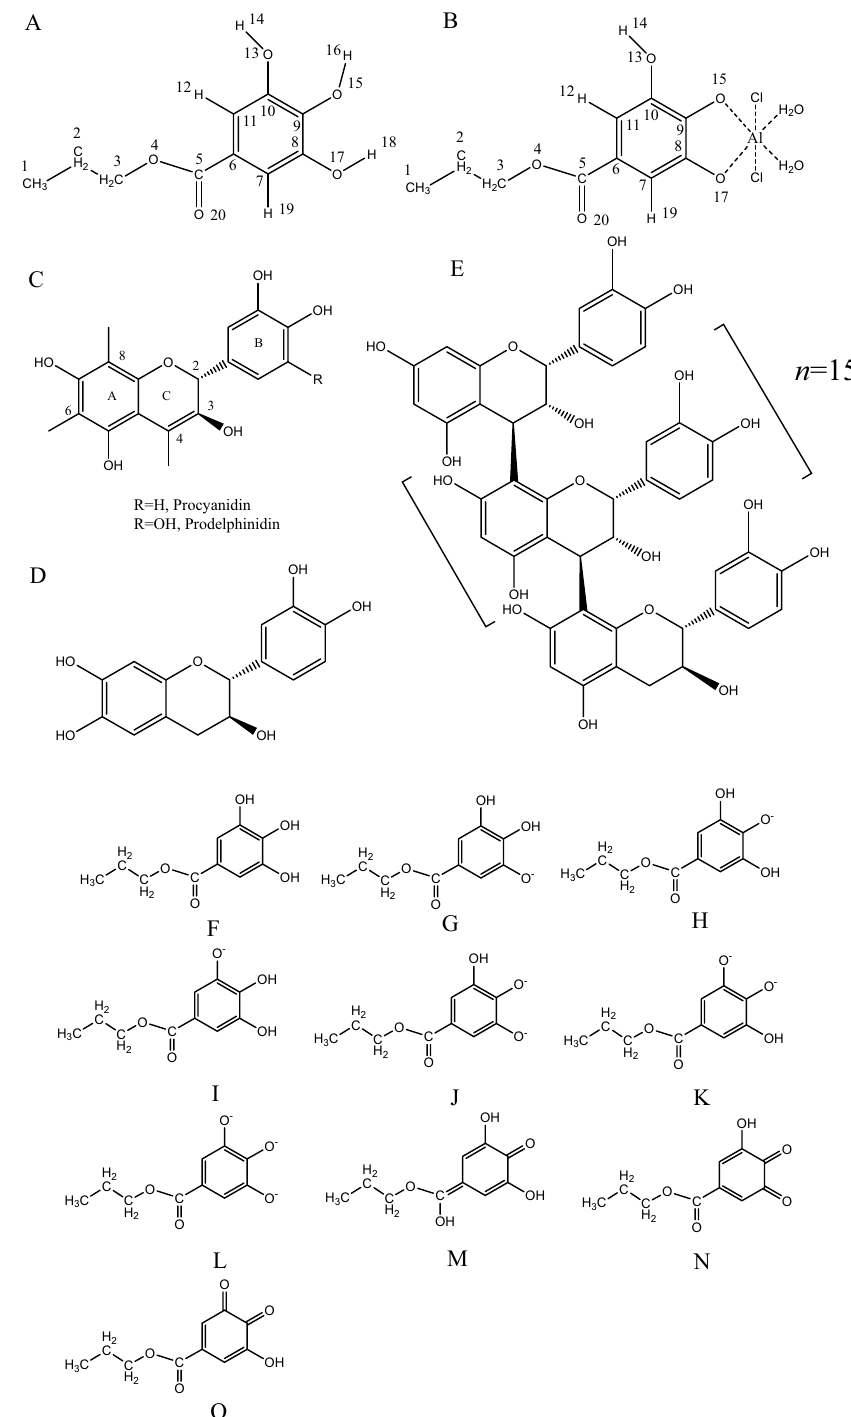
Figure 1. Molecular structures of ( A ) propyl gallate (PG), ( B ) PG-Al complex, ( C ) flavan-3-ol monomer of condensed tannin, ( D ) catechin and ( E ) PC; Propyl gallate (PG), proposed deprotonated and quinoid PG, and PG-Al complex structures used to calculate spectra by Gaussian software( F – O